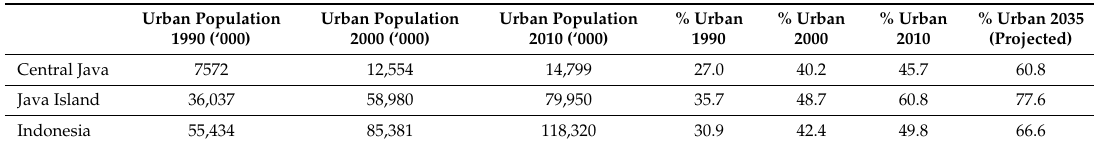
Table 3. Urban population growth in 1990, 2000, and 2010.